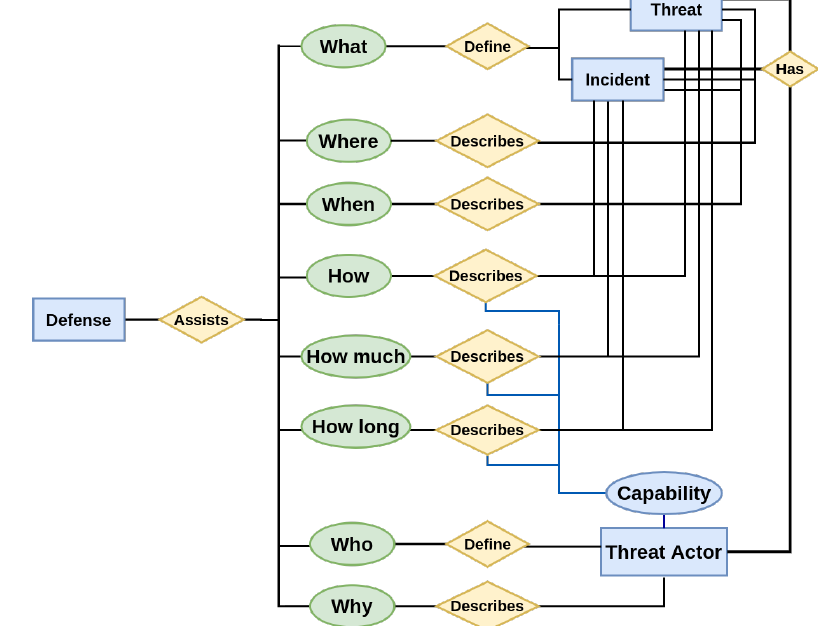
Figure 2. Main entities relationship